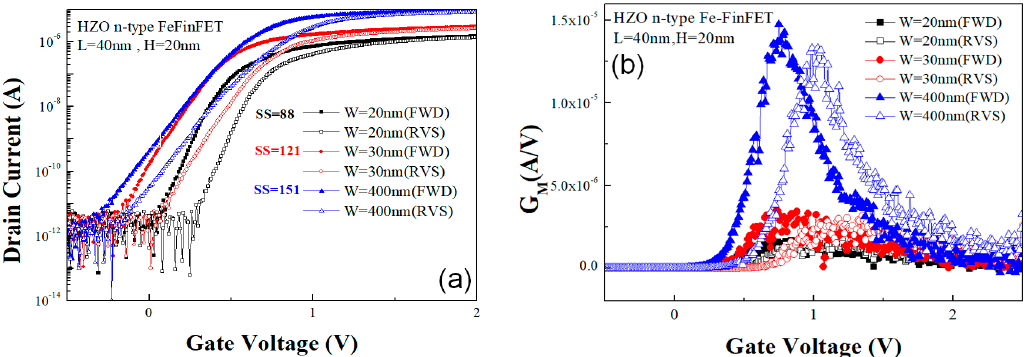
Figure 2. ( a ) I D ‐ V G characteristics and ( b ) transconductance for various fin ‐ widths of n ‐ type Fe ‐ FinFET.